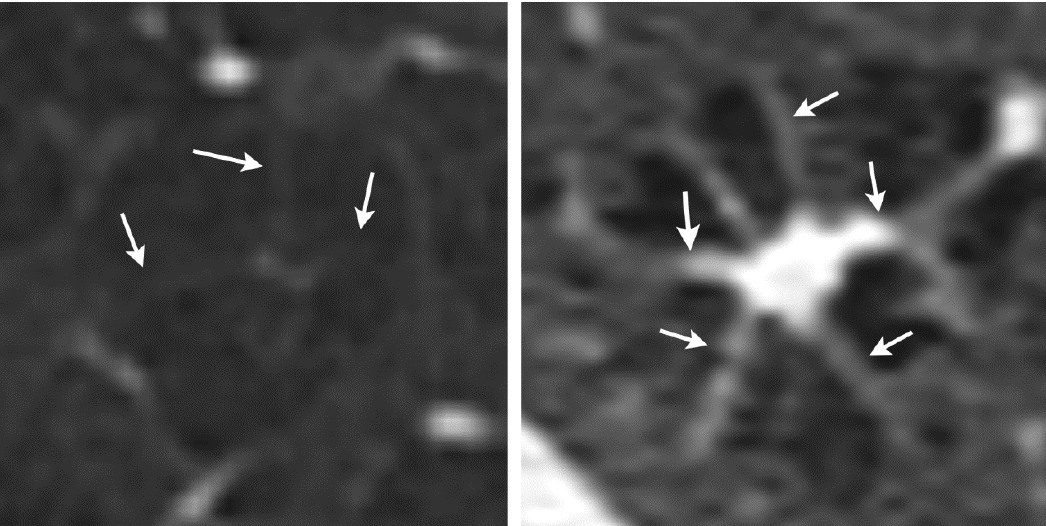
Figure 3. Comparison between centrilobular emphysema ( left ) and Langerhans cell histiocytosis ( right ). The strands (arrows) pointing to the center of the lesion in centrilobular emphysema are thinner than those in PLCH.